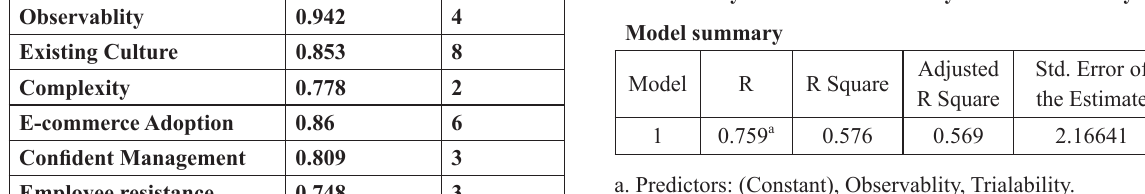
Summary Model for Trialability and Observability.